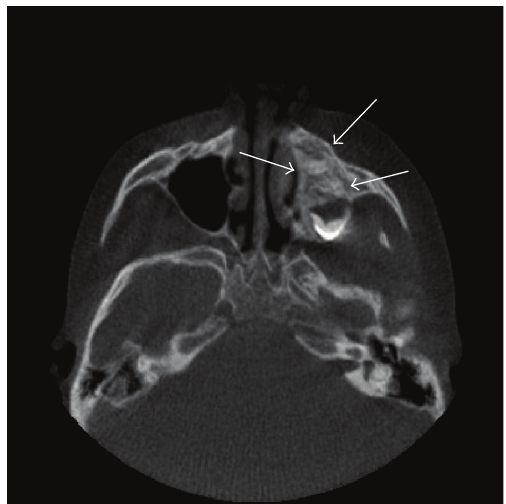
Figure 2: Axial cone beam computed tomography view showing left maxillary alveolar expansile lesion with a dystrophic, ill-defined trabecular pattern.